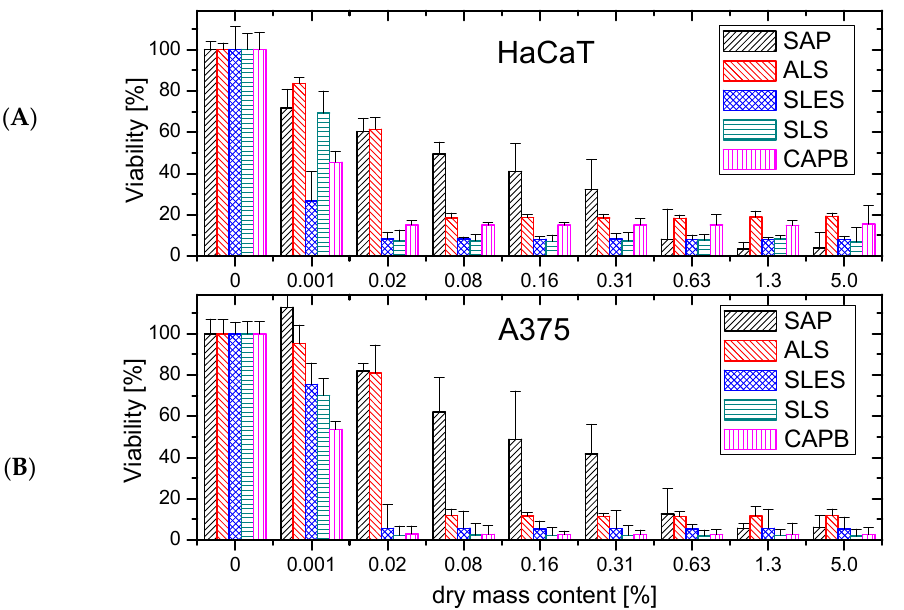
Figure 2. ( A ) The HaCaT (normal keratinocytes) and ( B ) A375 (melanoma cells) viability after 24 h of exposure to sodium lauryl sulfate (SLS), sodium laureth sulfate (SLES), ammonium lauryl sulfate (ALS), cocamidopropyl betaine (CAPB) and a saponin-rich extract from roots of soapwort (SAP). Table 1. EC 50 values expressed as dry mass content [%] for (bio)surfactants from Figure 2. EC 50 [Dry Mass Content, %] Cell Cell Line SAP